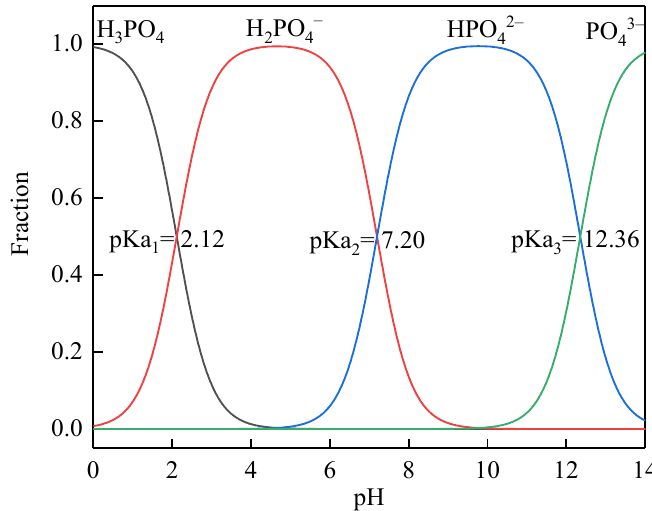
Figure 8. Distribution of phosphate species as a function of pH.